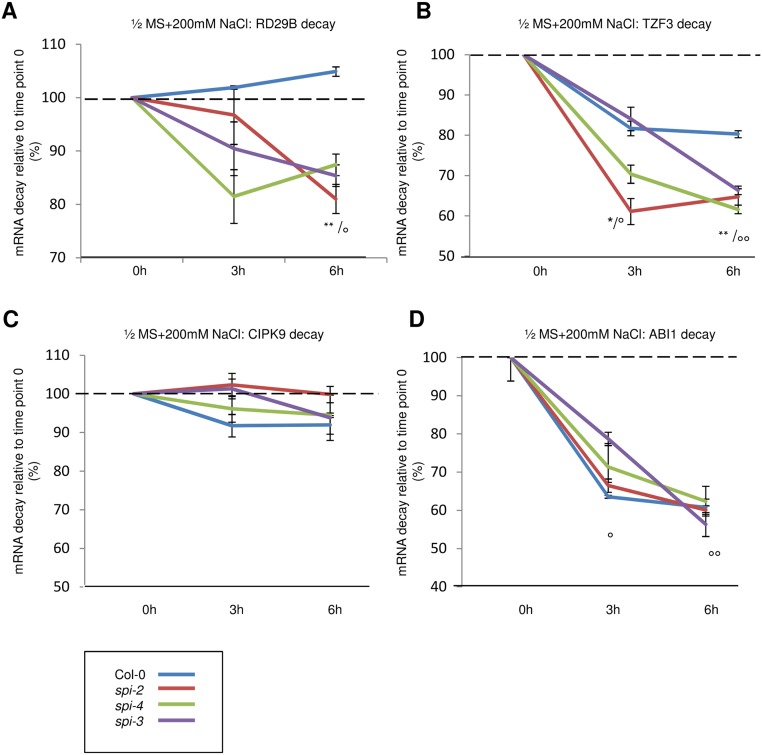
Role of SPI in the regulation of mRNA stability.mRNA stabilities (in %) were determined 3 h and 6 h after application of Actinomycin D (ActD) relative to time point 0 under salt stress conditions (200 mM NaCl in ½MS liquid medium for 4 h). mRNA decay was determined for RD29B (A), TZF3 (B), CIPK9 (C), and ABI1 (D). Data denote the average from three independent biological and two technical replicates. Error bars represent the standard error of the mean. Two-tailed student’s t tests were performed to compare 18S rRNA normalized expression levels either of spi alleles with that of wild-type (* p < 0.05; ** p < 0.01 of all spi alleles), or of ActD-treated samples with that of untreated samples (time point 0) (° p < 0.05; °°
p < 0.01 of all treated samples).